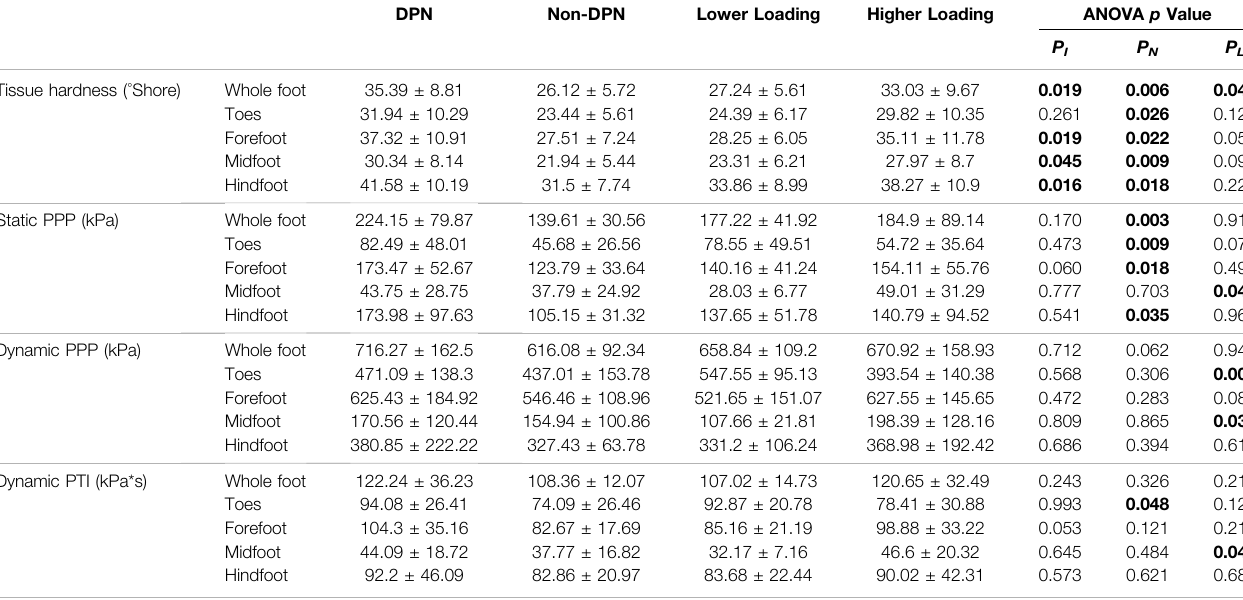
TABLE 2 | The interaction and main effects of peripheral neuropathy and plantar loading patterns on plantar tissue hardness and plantar pressure (Mean ± SD).